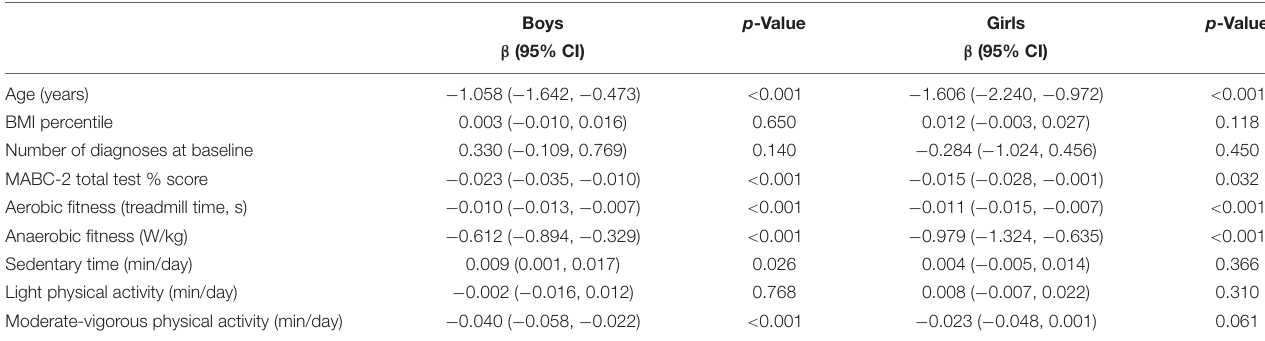
TABLE 2 | Crude associations of demographics, health-related physical fitness variables, motor coordination, physical activity, and sedentary time with body adiposity for boys and girls.